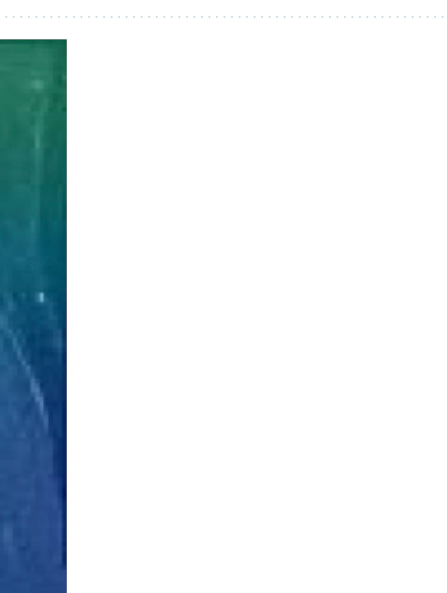
Figure 6. Two sample subjects, one with agreement between the dNN and the reader and the other with disagreement. As described in Fig. 2, the three slices were combined into a color image as shown in the top labels to facilitate classification by 2D image-based networks. ( a ) A subject where the dNN and reader assessments agreed with the OAI class (both giving a value of 0). ( b ) A subject where the dNN agreed with the ground truth of normal fluid amounts, while the reader estimated effusion.